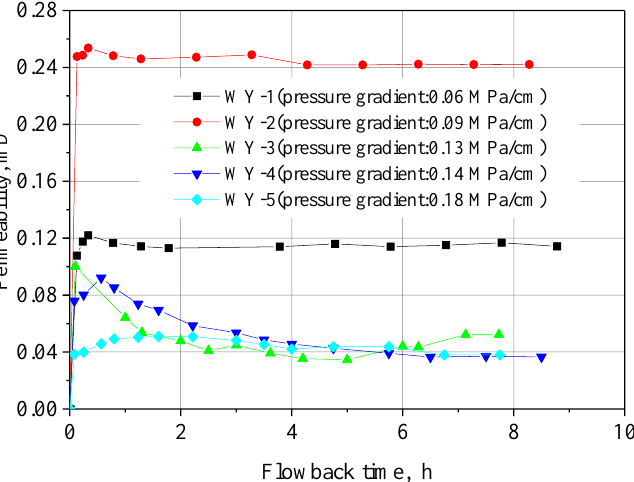
Figure 3. Relationship between permeability and flowback time of five shale samples under different flowback pressure differences.